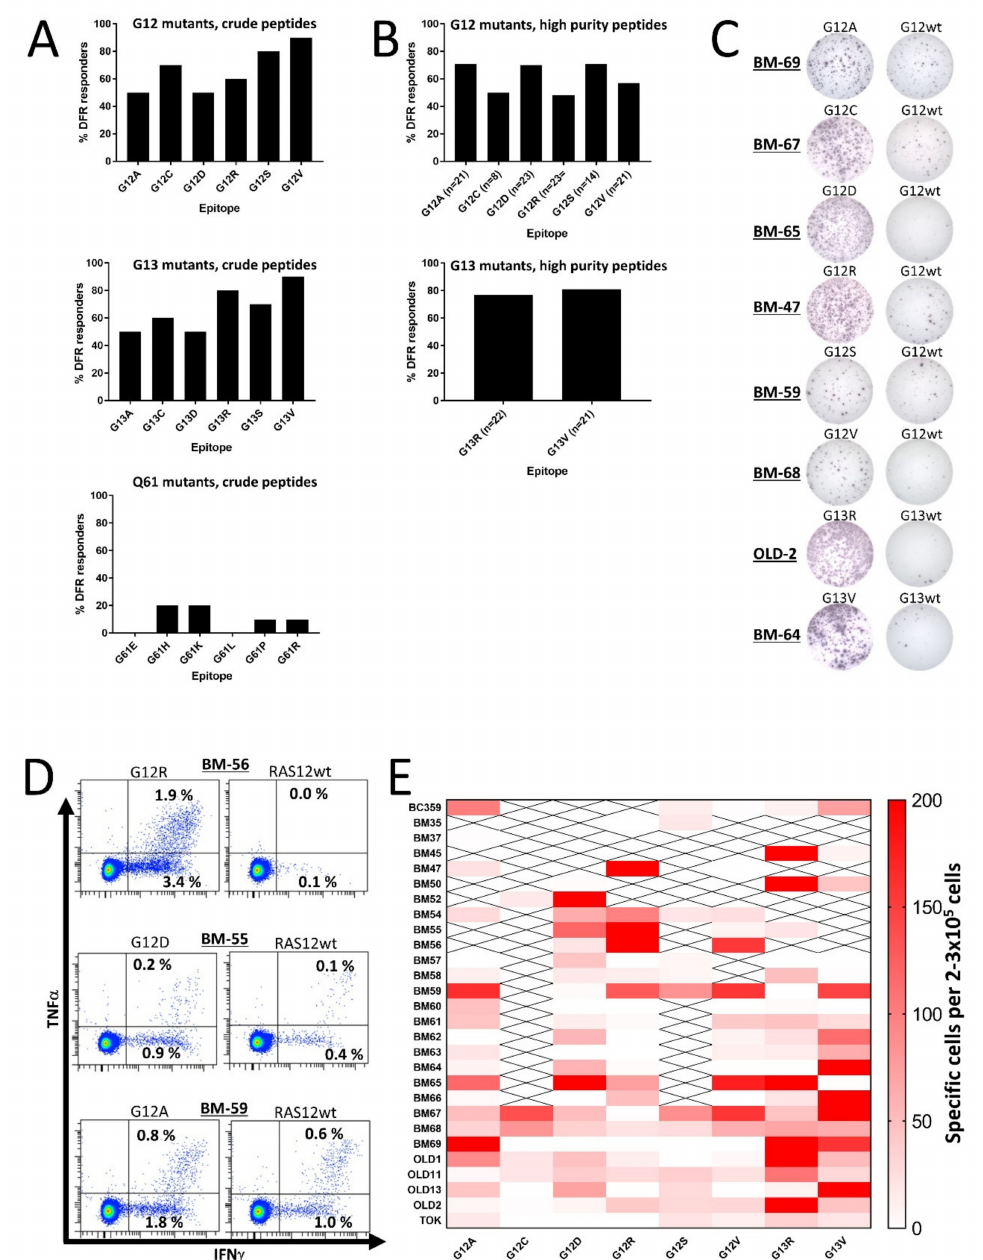
Figure 1. In vitro interferon (IFN)- γ enzyme-linked immunospot (ELISPOT) responses against RAS-mutant neo-antigens in healthy donor peripheral blood mononuclear cells (PBMCs). PBMCs were stimulated once in vitro and the next day with low-dose interleukin (IL)-2, and then incubated for 12–14 days before the restimulation of cells in a IFN- γ ELISPOT. ( A ) The frequency of responses in PBMCs from 10 healthy donors (HDs) against crude RAS mutant peptide epitopes derived from the codon 12 (top), codon 13 (middle), and codon 61 (bottom) mutations. Responses were defined according to the distribution-free resampling (DFR) method [28]. ( B ) The frequency of responses against high-purity RAS mutant peptide epitopes derived from the codon 12 mutations (top), and those against the G13R and G13V substitutions derived from the codon 13 mutations (middle). Responses were defined according to the distribution-free resampling (DFR) method [28]. The n = xx depicted under each bar shows how many donors were tested against the peptide of interest. ( C ) Representative raw results from panel B. ( D ). Examples of responses identified by intracellular cytokine staining in healthy donor CD4 + T cells against the G12R, G12D, and G12A peptides. ( E ) Heatmap depicting the amplitude of the response against the high-purity peptide epitopes, with the wild-type (wt) epitope as a negative